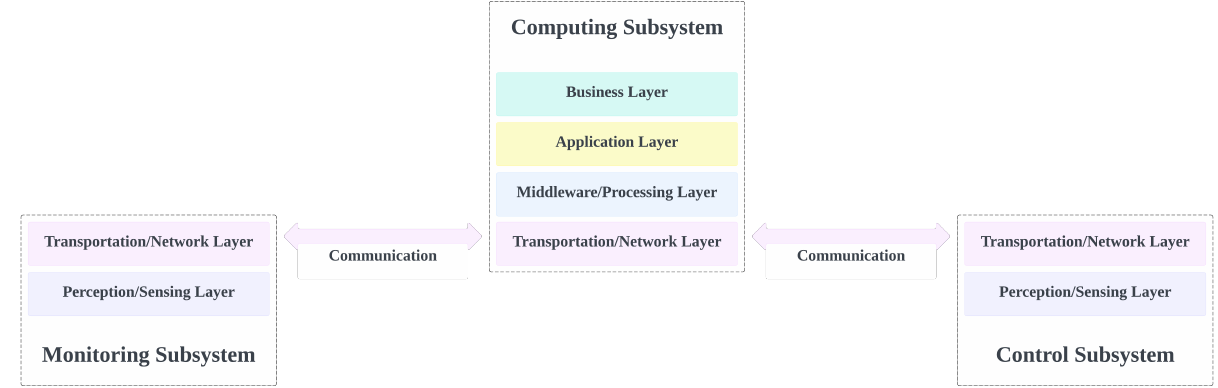
Figure 14. MCF subsystems assembled. The monitoring subsystem and control subsystems both have two architecture layers (transportation/network layer and perception/sensing layer), and the computing subsystem has four architecture layers (business layer, application layer, middleware/pro- cessing layer, and transportation/network layer). All three subsystems communicate with each other at the transportation/network